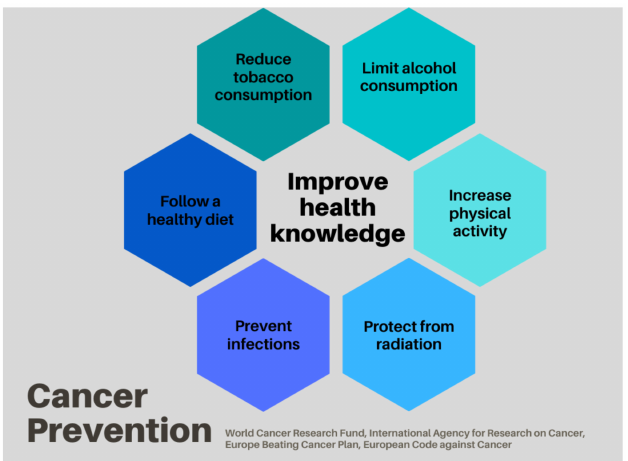
Figure 2. All cancer prevention strategies described can be grouped into these strategies. The figure is based on recommendations from the World Cancer Research Fund, International Agency for Research on Cancer, Europe Beating Cancer Plan, and the European Code Against Cancer